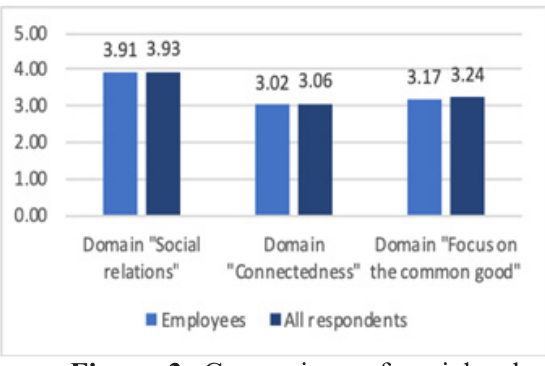
Figure 3. Comparison of social cohe-